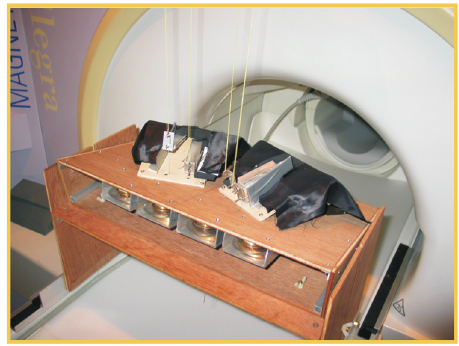
Figure 1. Device for passive movement stimulation. Picture of the MR compatible device for passive motor stimulation of the index- and middle- fingers of the left and right